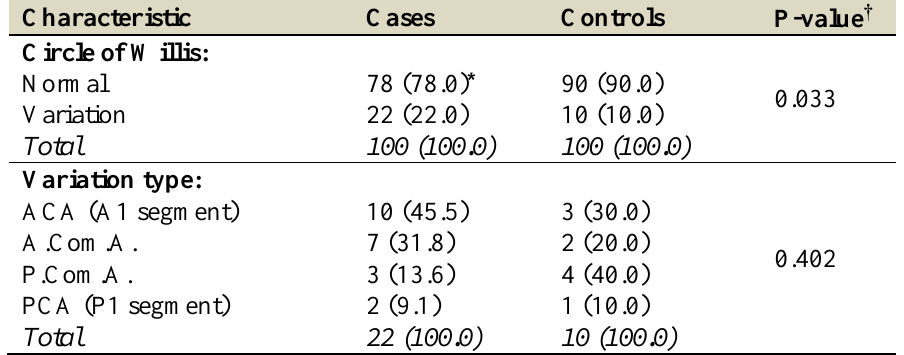
Table 2. Anatomical variations of the circle of Willis in patients with subarachnoid hemorrhage